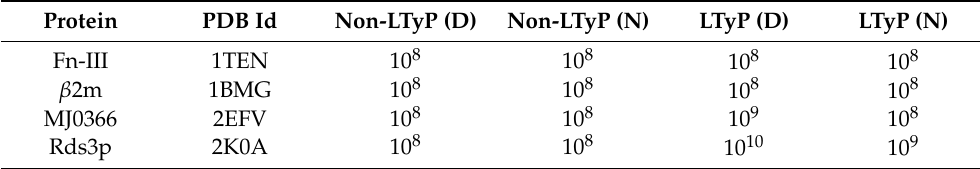
Table 1. Number of Monte Carlo steps (mcs) required for a simulation to achieve thermal equilibrium. Simulations starting from a denatured conformation are designated (D), and those starting from the native conformation are designated